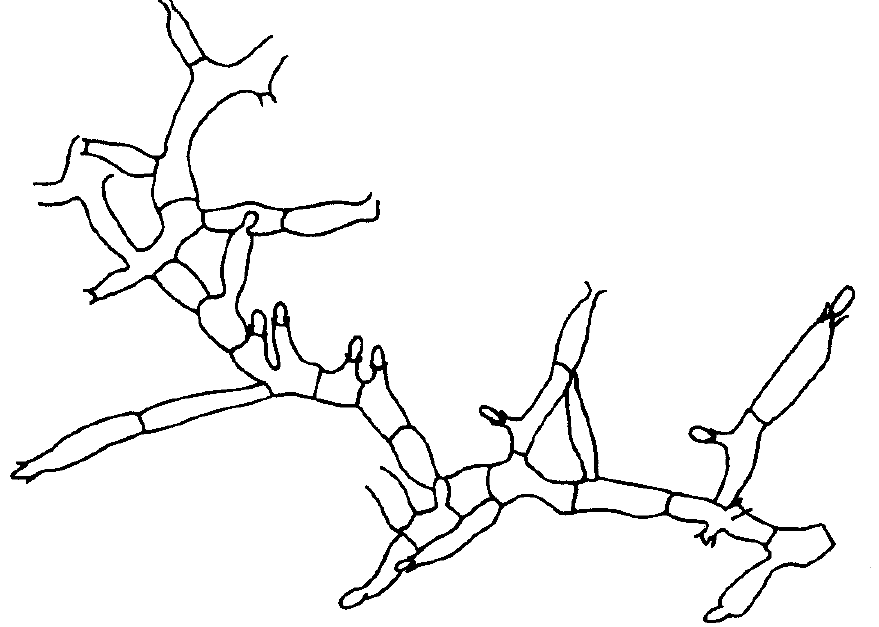
Fig. 3. Phaeoacremonium chlamydosporum – sub-surface hyphae and conidiogenous cells from below the surface of PDA culture (VPRI